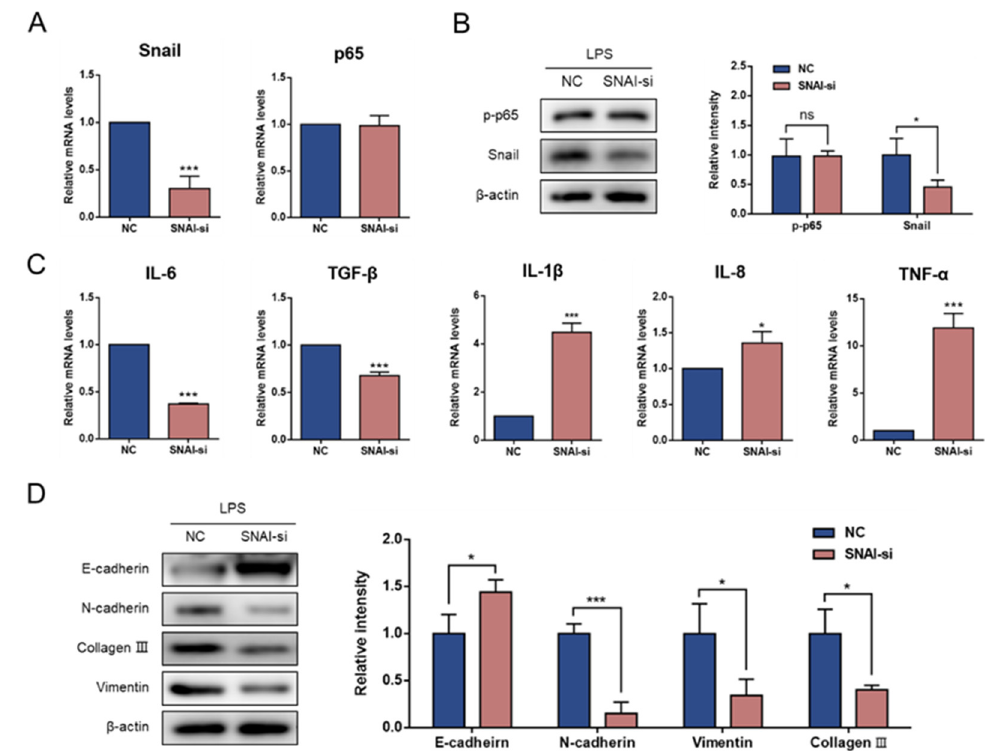
Figure 4. Snail knockdown changed the expression of inflammatory cytokines and EMT markers. Snail–siRNA was transfected into GMECs after LPS treatment for 14 d. ( A ) mRNA expression levels of p65 and Snail after Snail knockdown. ( B ) Western blotting results of p65 and Snail after Snail knockdown. (original western blot figures in Figure S8). ( C ) mRNA expression levels of inflammatory cytokines after Snail knockdown. ( D ) Western blotting results of EMT markers. (original western blot figures in Figure S9). * Indicates a significant difference compared with the NC group, * p < 0.05, *** p < 0.001.